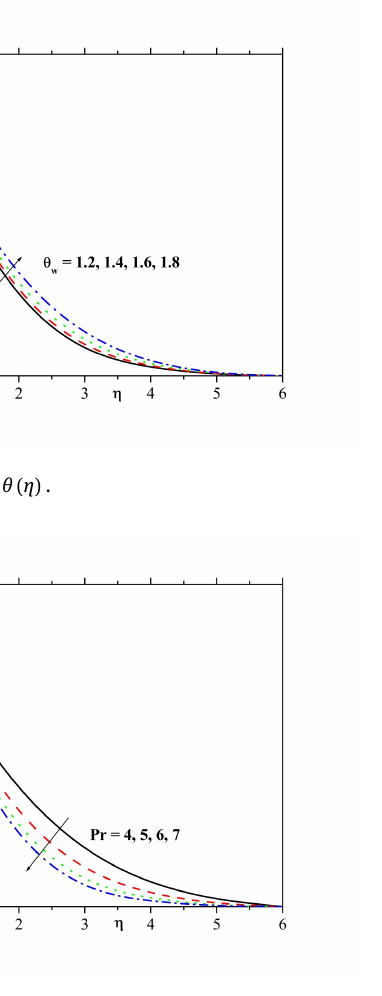
Fig. 8: Influence of Pr on θ ( η ) .